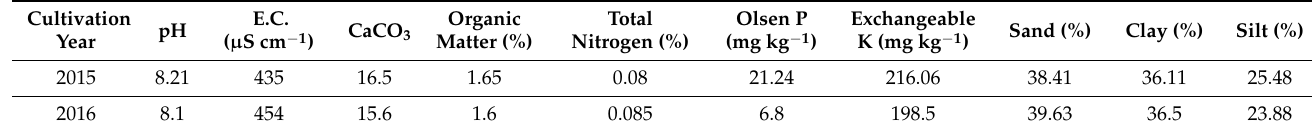
Table 7. Physicochemical properties of the soil